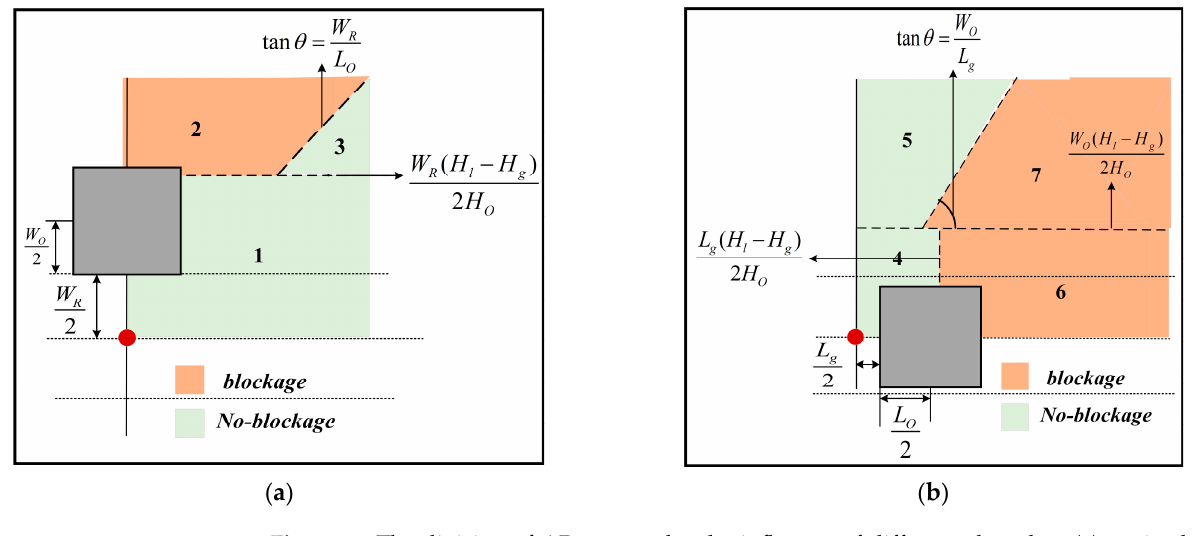
Figure 4. The division of AP area under the influence of different obstacles: ( a ) static obstacle; ( b ) dynamic obstacle.